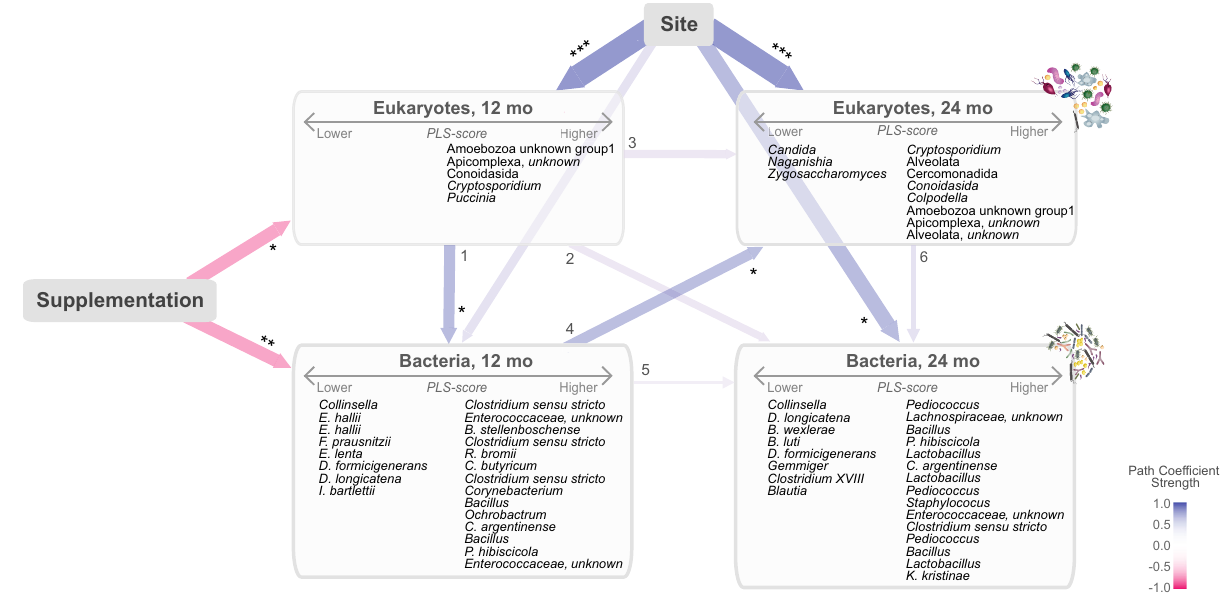
Fig. 5 Graphic representation of the cross-associations among demographic variables, micronutrient supplementation, and microbiota at 12 and 24 months. Interconnected arrows indicate the tested cross-correlated paths between: place of residence (site), supplementation, and the community patterns of bacterial and eukaryotic OTUs summarized as latent PLS scores. Paths represent composites of direct and indirect effects among variables. Negative correlations are indicated in pink and positive in blue. Arrow thickness is weighted by the coef fi cient strength of the direct effect as detailed in Supplementary Data 6. Signi fi cance of direct effects, * p < 0.05, ** p < 0.01, and *** p < 0.0001. OTUs that loaded positively (>0.4) or negatively (< − 0.4) within each PLS-score are listed within boxes. PLS, partial least square; OTUs, operational taxonomic